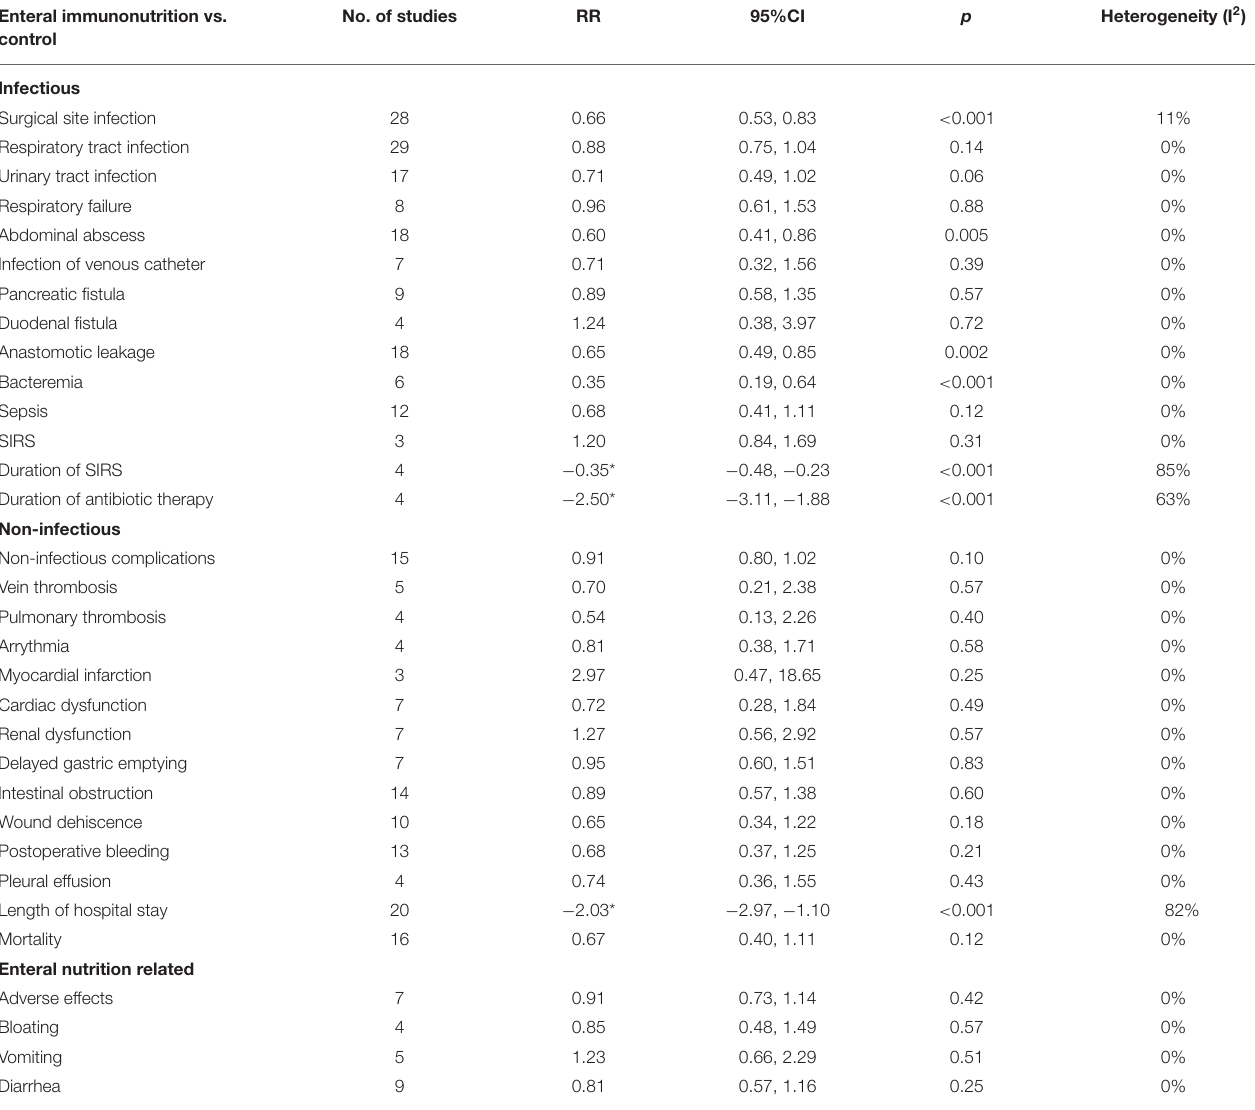
TABLE 2 | Analysis of enteral immunonutrition outcomes. Enteral immunonutrition vs.